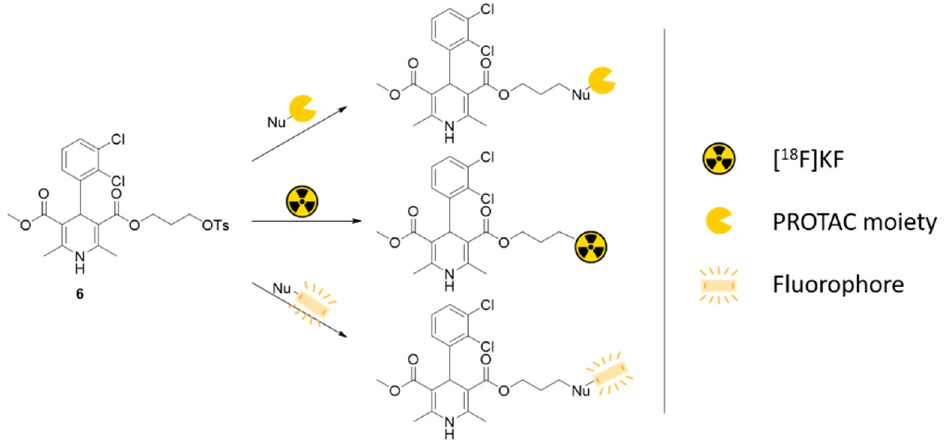
Figure 1. Examples of possible derivatization starting from 6 to access radioligands, PROTACs or fluorescent ligands.